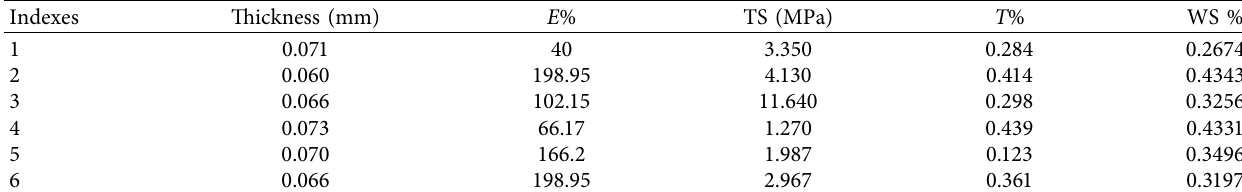
Table 2: Test data randomly selected for principal component analysis.